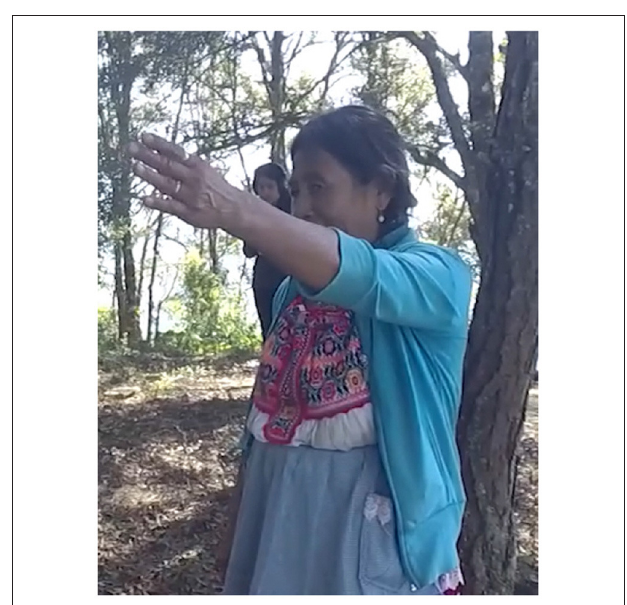
FIGURE 3 | District scale [target: ke A ku E suq C